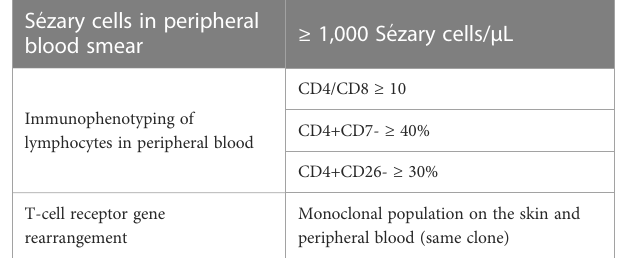
TABLE 1 Se ́ zary syndrome diagnostic